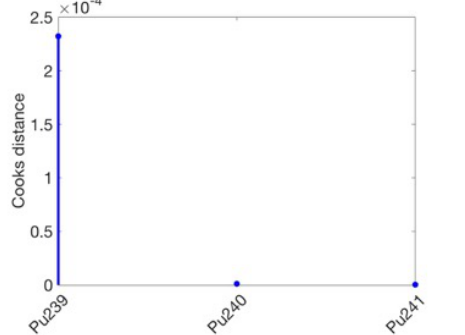
Figure 1. Cook’s distance for Pu isotopes